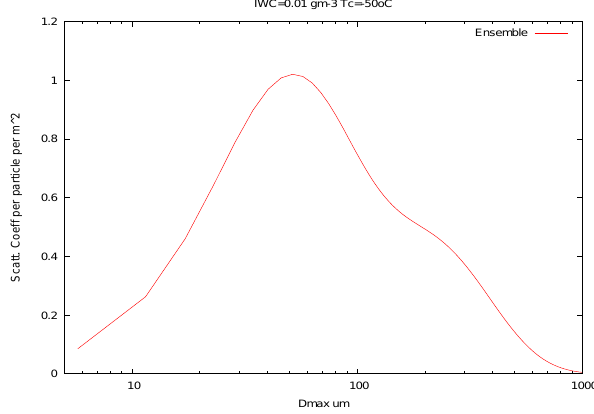
Figure 5. The scattering coefficient per particle (m − 2 ) as a function of ice crystal maximum dimension, D max . The PSD was generated assuming IWC and in-cloud temperature values of 0.01gm − 3 and − 50 ◦ C,